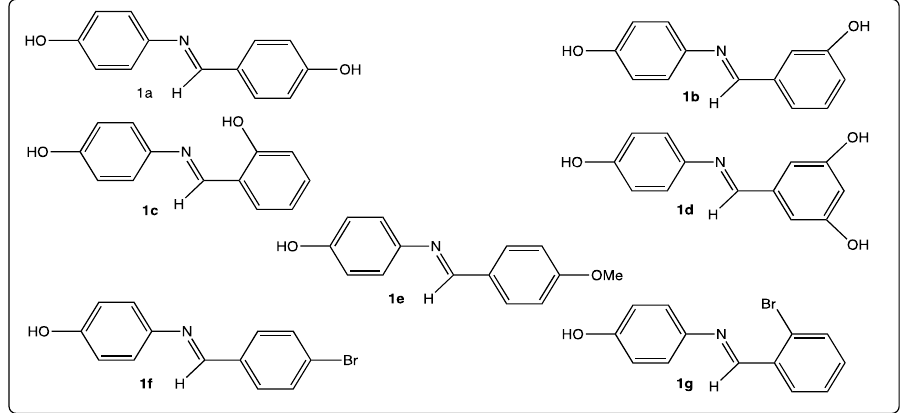
Figure 2. Structure of aza ‐ stilbenes 1a –